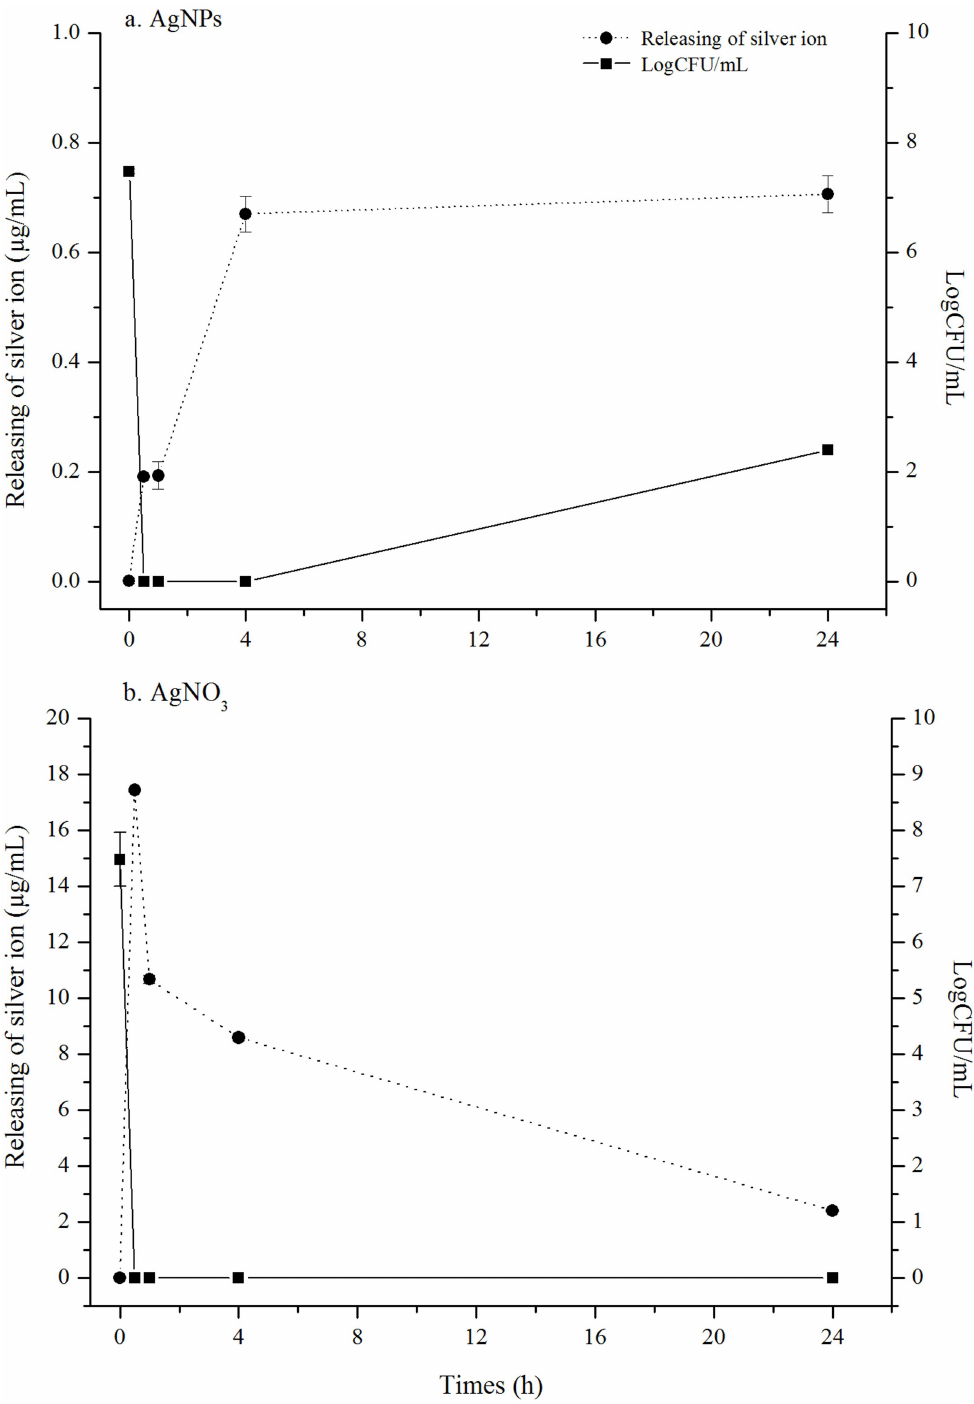
Fig 5. Kinetics of silver ion releaseon B . pseudomallei 316c. B . pseudomallei 316c was treated with AgNPs and AgNO 3 at 48 μ g/mL for 0, 0.5,1,4 and 24 h at 37˚C. The silver ion release was measuredusing ICP-OES technique.The killingkinetic was measuredusing dilutionplate count method. Both of data are the mean of two experiments performed in